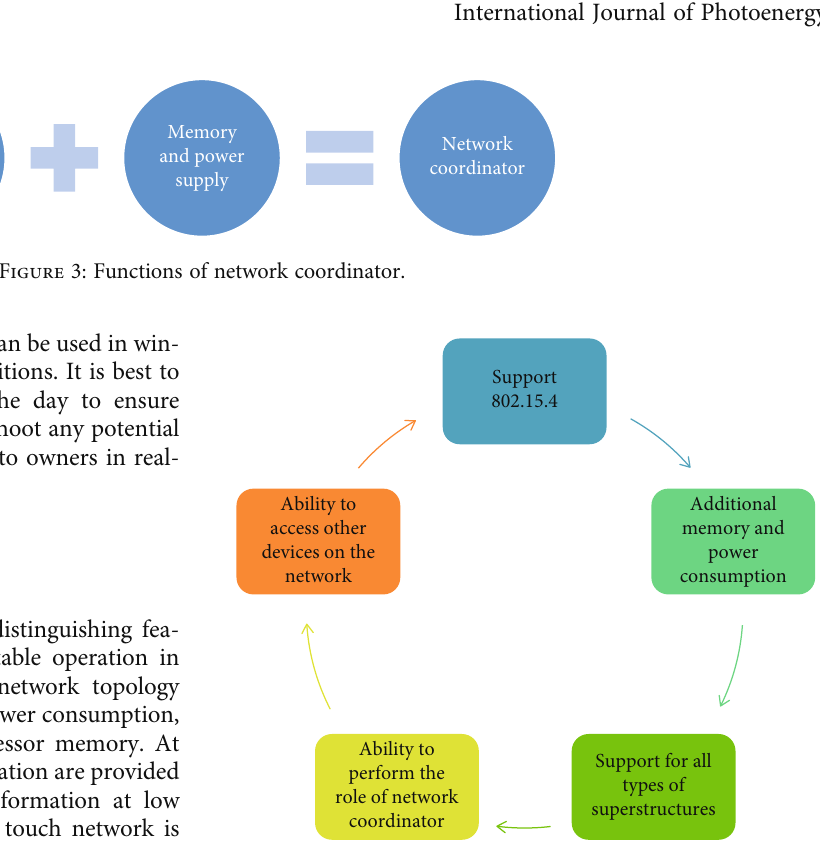
Figure 4: The performance parameters of fully functional device